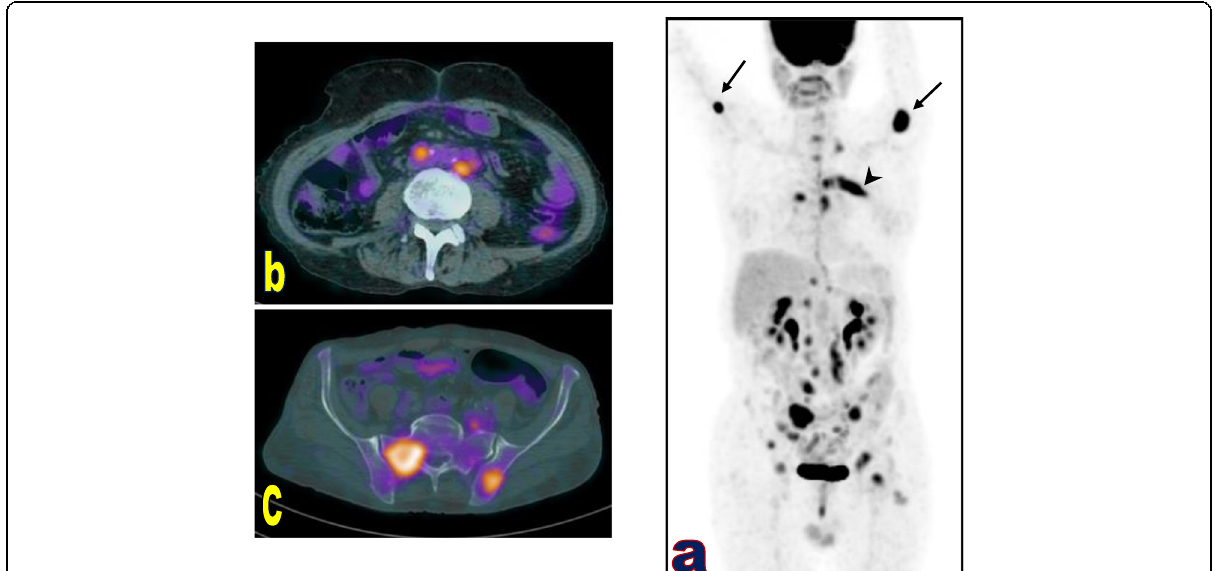
Fig. 4 3D MIP ( a ) and axial fused PET/CT images ( b and c ) for a 60-year-old male patient underwent surgical excision of gastric adenocarcinoma followed by radiation and chemotherapy. No FDG avid lesions at the operative bed. Increased FDG uptake by multiple lymph nodes involving porto-caval, para-aortic, aorto-caval, retro-caval, bilateral common iliac, left internal and right external iliac groups as well as mediastinal lymph nodes (left infra-clavicular, pre-vascular, hilar, retro-crural, and posterior mediastinal groups). Multiple mainly lytic lesions involving the humeri (black arrows), few thoracic vertebrae, left sixth rib with soft tissue component (arrow head), sacrum, pelvic bones, and upper left femur. Final diagnosis obtained by radiological follow-up for